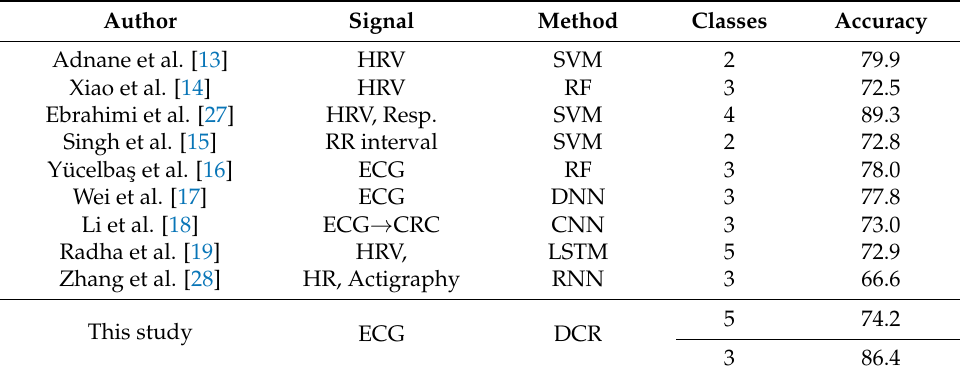
Table 5. Comparison of ECG-based sleep stage scoring